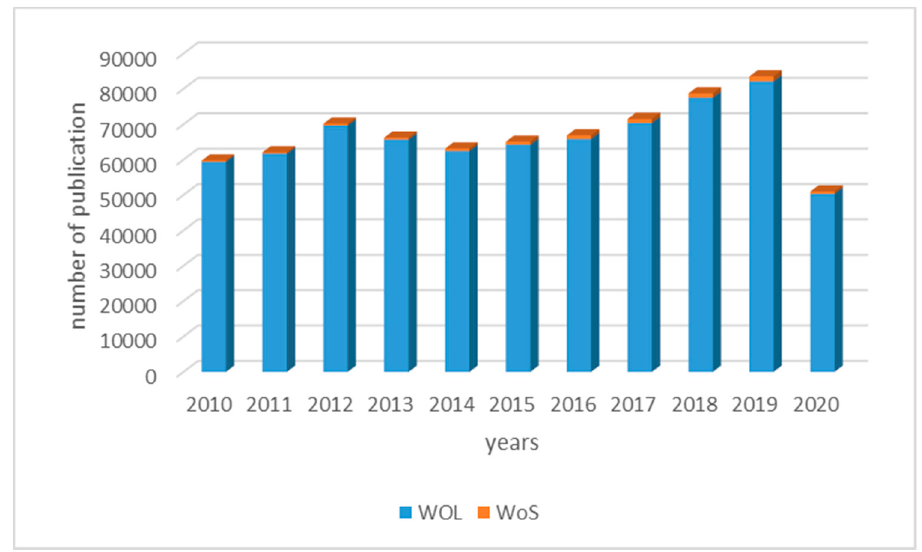
Figure 3. Number of papers from selected databases by year (WOL—Wiley Online Library; WoS—Web of Science).